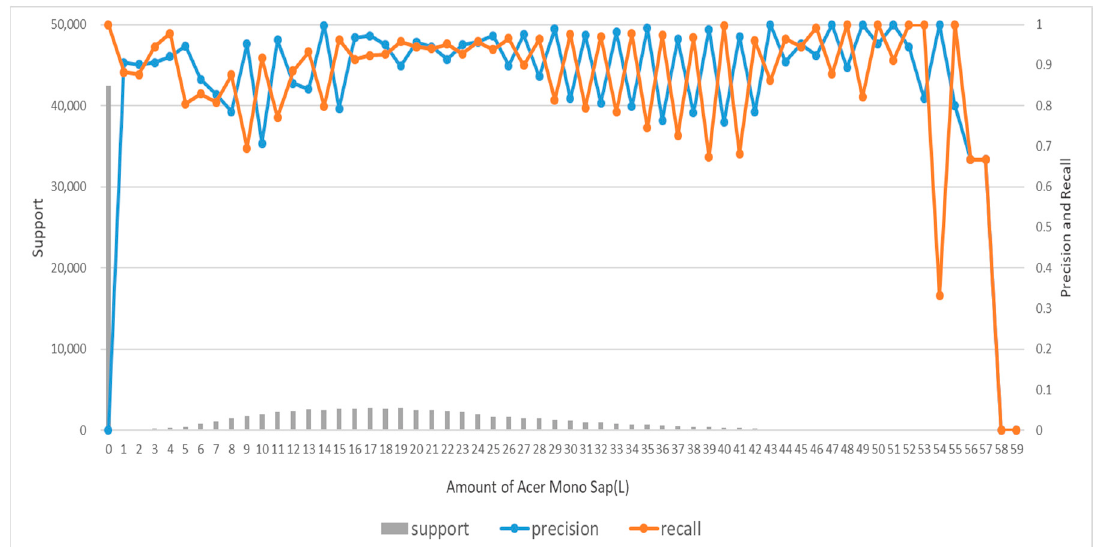
Figure 19. Prediction accuracy of ANN optimal model. Table 8. Prediction accuracy of model based on ANN learning Table 7. Configuration of ANN model.